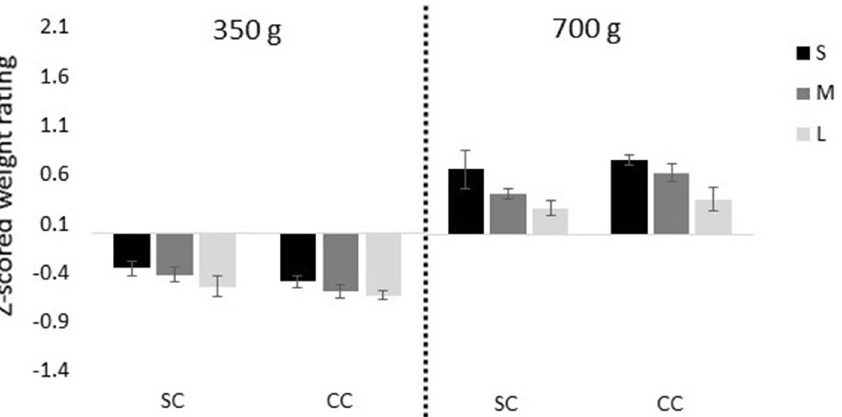
Figure 5. Experiment 2 (with only visual size information); average z-scored weight ratings for the Small (S), Medium (M) and Large (L) cubes for the Sighted Control group (SC) and Congenital Cataract group (CC), for the 350 g and 700 g weights. Error bars depict standard error of mean (SEM).